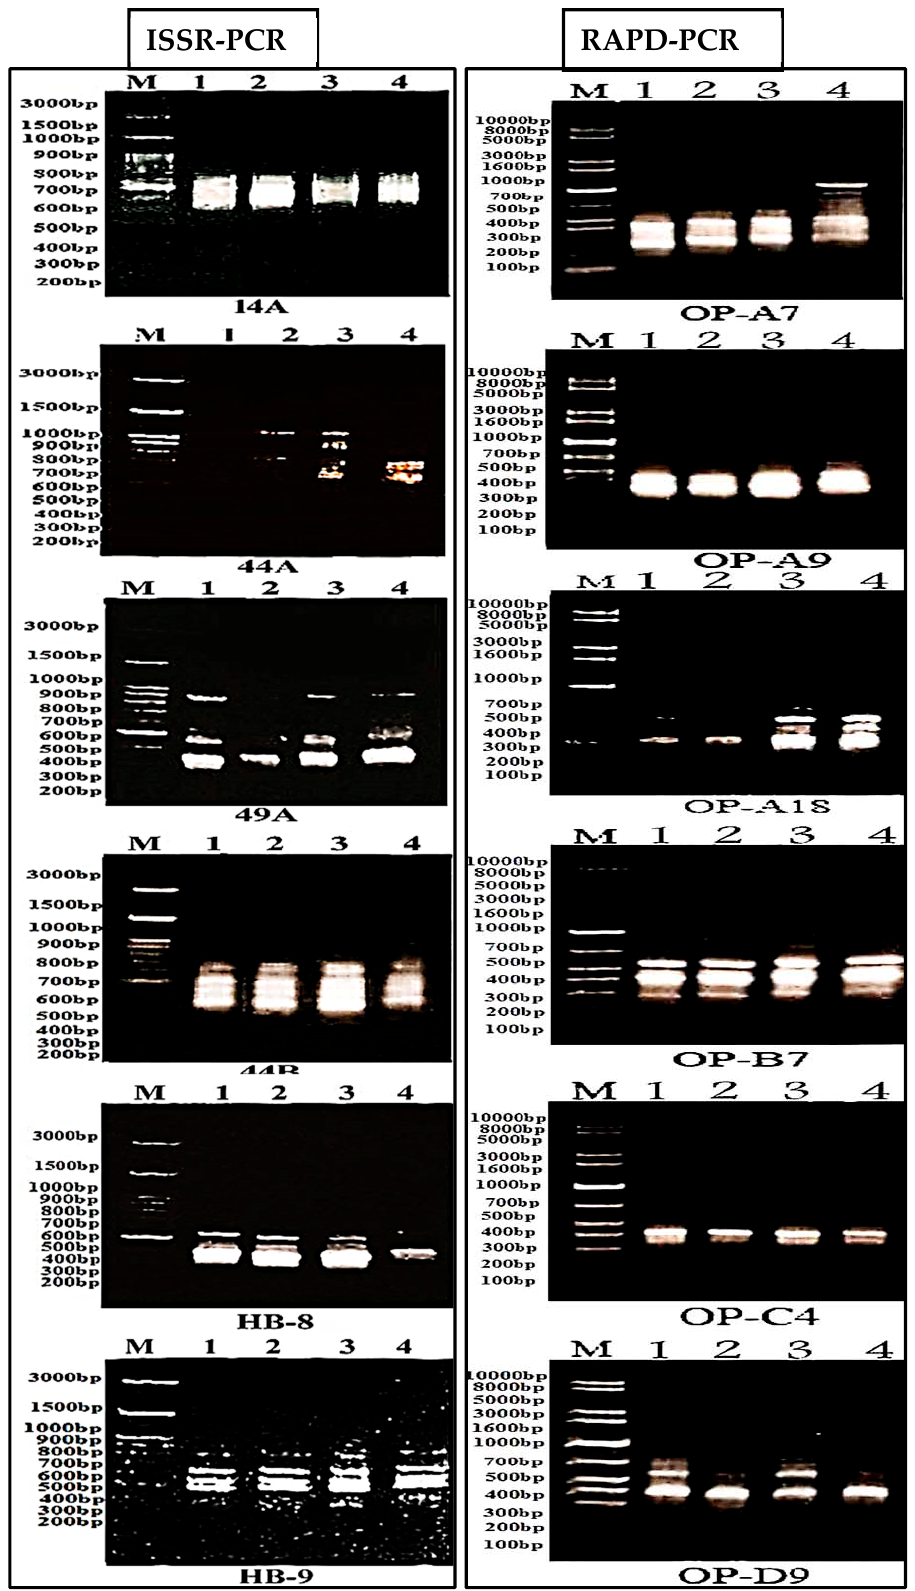
Figure 3. Random amplified polymorphic DNA (RAPD) and inter simple sequence repeat (ISSR) profiles of Onopordum alexandrinum genotypes generated with di ff erent six primers. Lanes 1–5 represented the sample habitats. M = Molecular size marker. 1 = Oa1 (sand dunes), 2 = Oa2 (abandoned fields), 3 = Oa3 (barley fields), 4 = Oa4 (desert